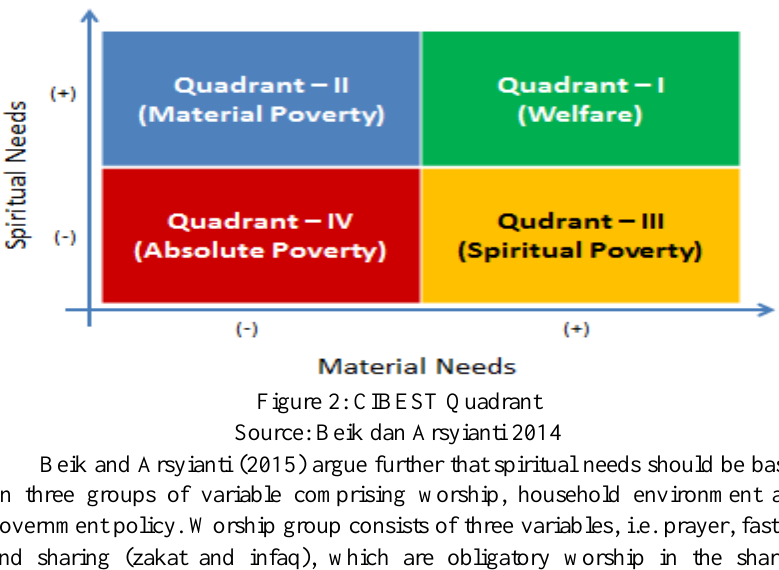
Figure 2: CIBEST Quadrant Source: Beik dan Arsyianti